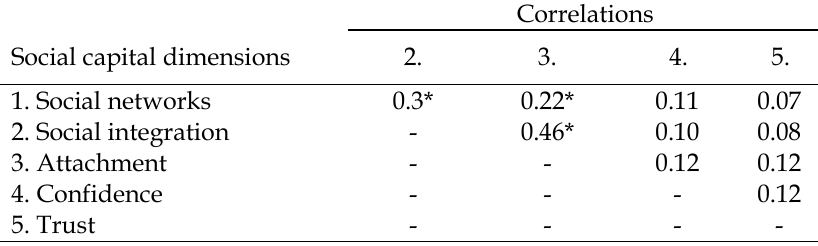
Table 2. Correlations between social networks, social integration, attach- ment, confidence and trust